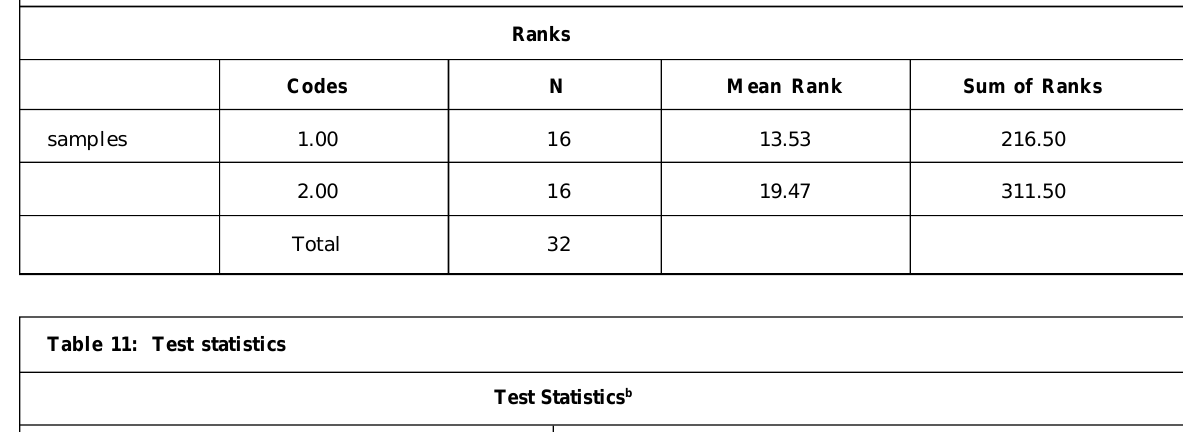
Table 10: Ranks for the C. myrrh extract (code 1.00) and the barbicide solution(code 2.00).